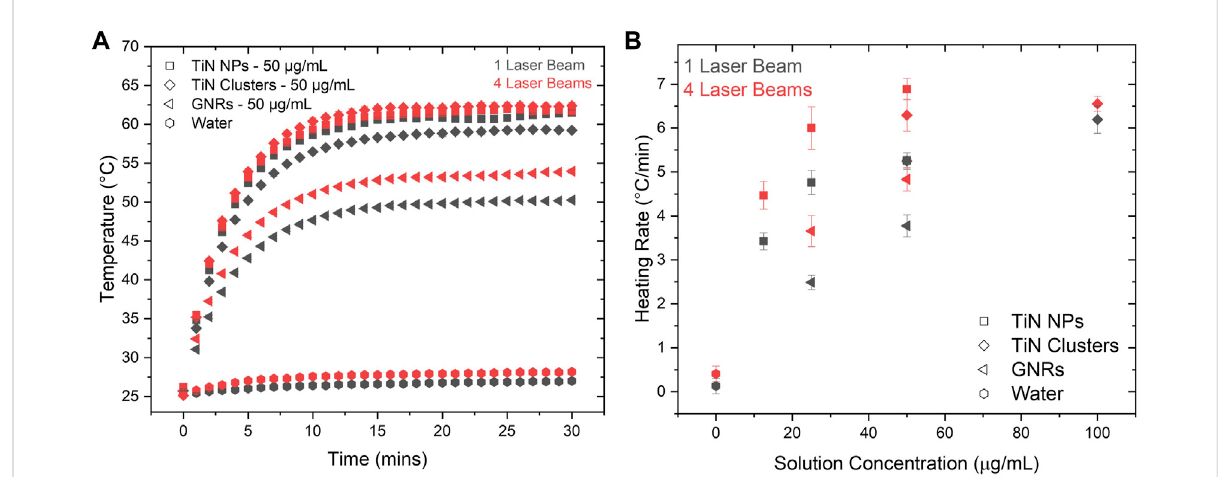
FIGURE 3 Heating rate comparison between laser setups. (A) Temperature increments as a function of time in TiN NPs, TiN clusters, and GNRs at 50 μ g/ mLconcentrationswithavolumeof500 μ L.Thisgraphshowsthedifference inphotothermalheatingfor1LBand4LBsetups. (B) Theheatingrateof TiN NPs, TiN clusters, and GNRs at various concentrations showing the difference between 1LB and